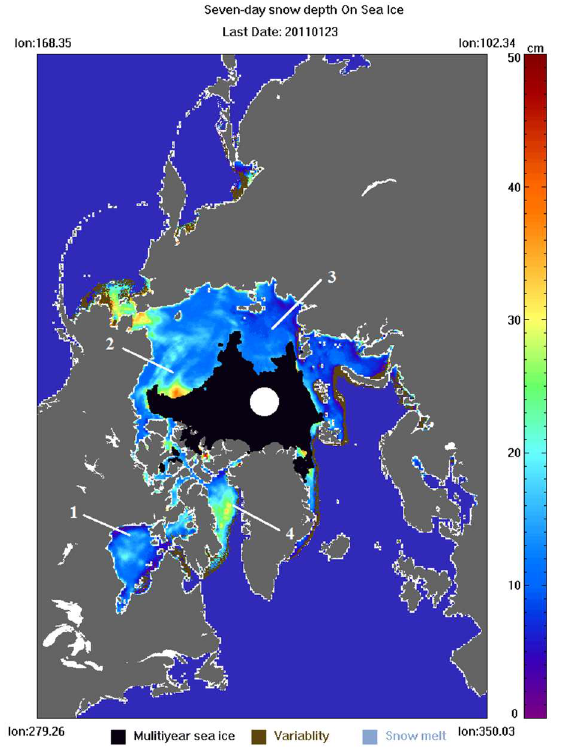
Figure 9. Positions of the selected points The plots of the snow depth at 4 points accompanied with the averaged snow depth in the arctic were drawn in Fig. 10. It illustrates that for point 1, the peak of the snow depth appeared in January, and the values are smoother at the rest of the time. Similarly, snow depth of point 2 and point 4 reached the peak at January and declined smoothly later. While point 3 shows a Figure 8. The sea ice concentrations from ASI minus that different trend that was generally smooth during the whole period. from NT2 on January 23, 2011 But for the whole Arctic, the average snow depth increases smoothly and reaches the highest in mid